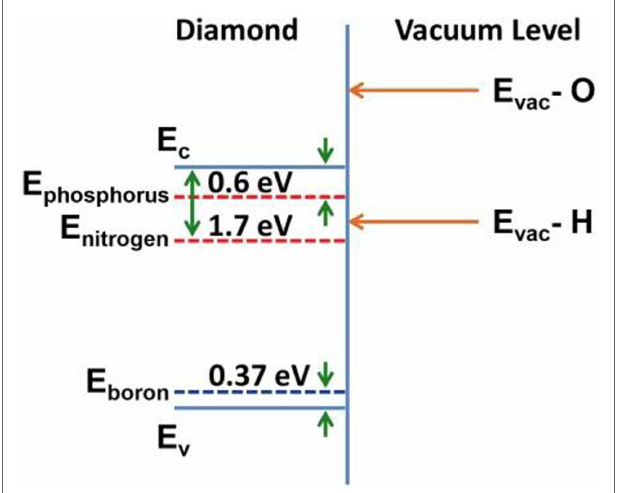
FIGURE 3 | Schematic band structure of diamond with donor levels (nitrogen, phosphorus), boron acceptor, and negative electron affinity for hydrogen passivated surface, conduction, and valence band indicated by E c and E v , respectively.